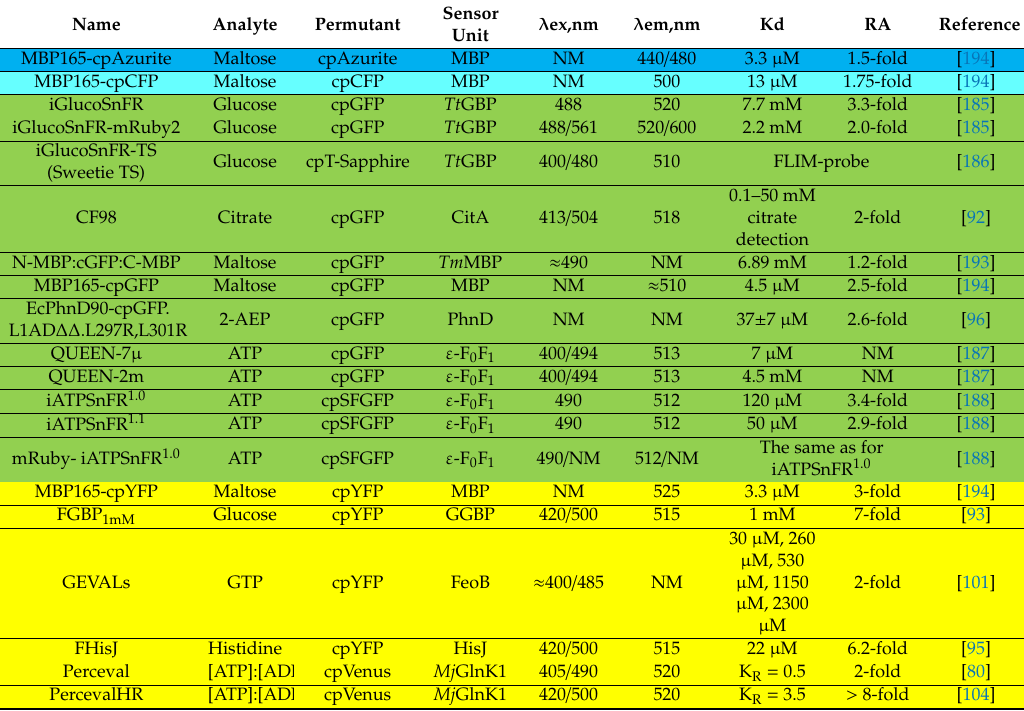
The raw colors refer to the colors of fluorescent proteins used as reporter domains. Kd—dissociation constant. NM—not measured. RA—response